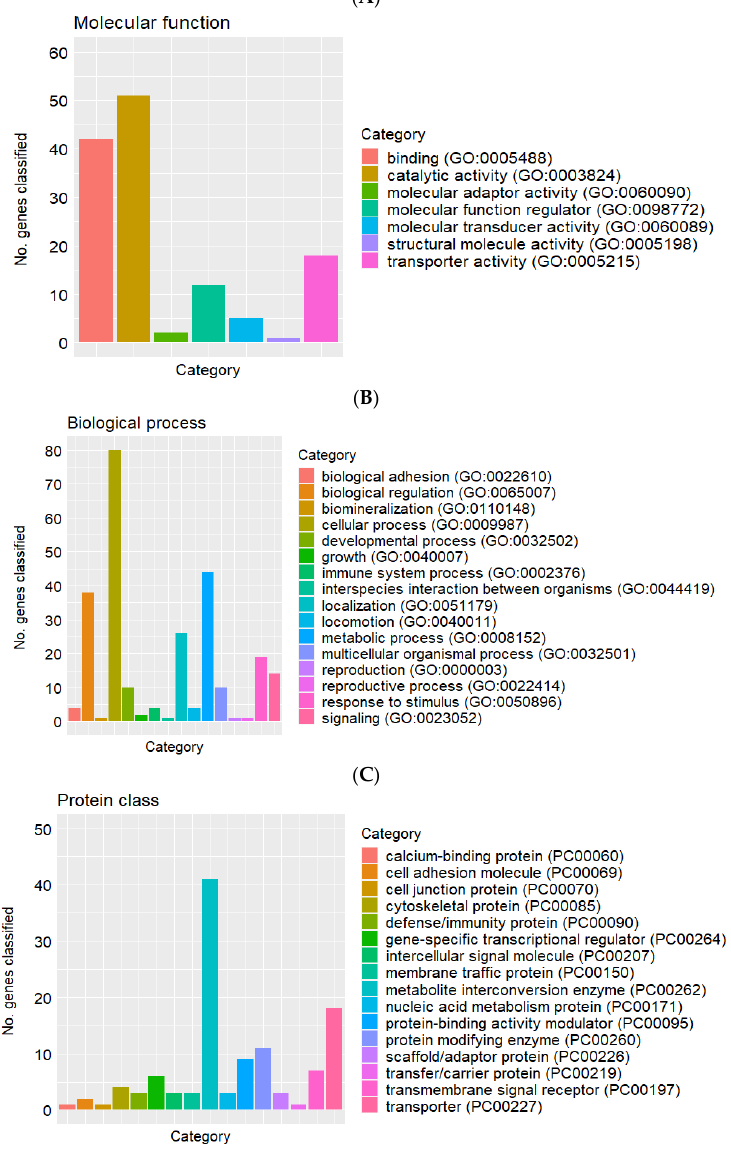
Figure 2. Functional classification of differentially expressed genes in placentae between heat stress ( n = 5) and control ( n = 5) groups in the gene ontology (GO) domains of ( A ) Molecular function, ( B ) Biological process and ( C ) Protein class. The upregulated and downregulated DEGs (HS compared with CON) were analysed separately by the statistical overrepresentation test, and the GO terms significantly